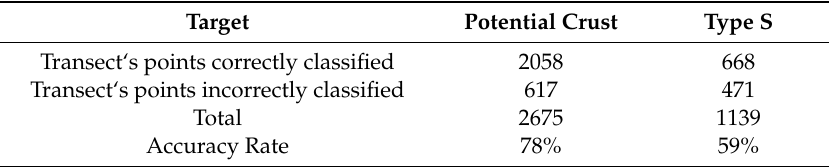
Table 2. Accuracy of spatial distribution map of Fe–Mn crust